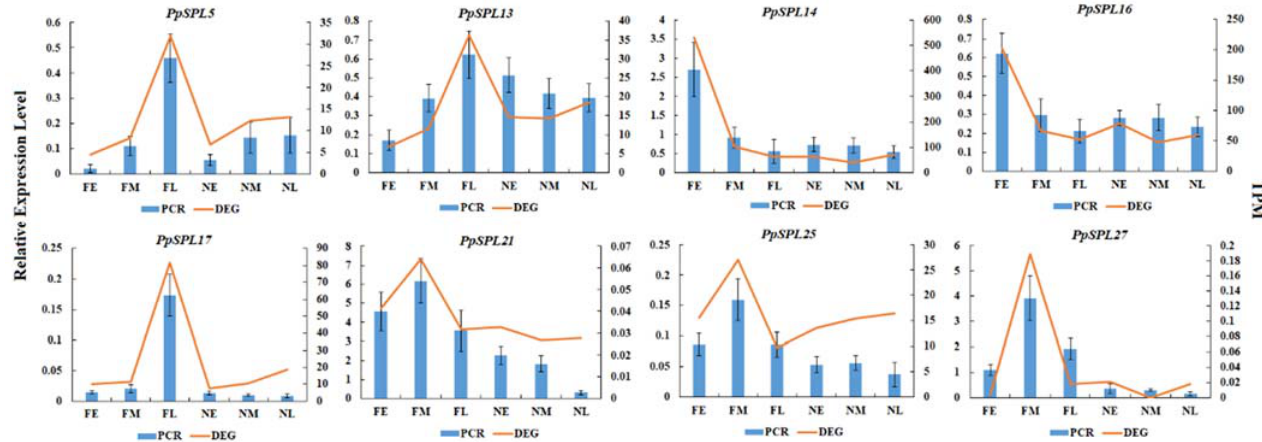
Figure 6. RT-qPCR validation of significant, differentially expressed PpSPLs in Pleioblastus pygmaeus . FE, dormant shoot buds from flowering P. pygmaeus ; FM, germinated shoots from flowering P. pygmaeus ; FL, flower buds from flowering P. pygmaeus ; NE, dormant shoot buds from non-flowering P. pygmaeus ; NM, germinated shoots from non-flowering P. pygmaeus ; NL, leaf buds from non-flowering P. pygmaeus ; PCR, relative expression level by RT-qPCR; DEG, differentially expressed gene by RNA- Seq; TPM, Transcripts Perkilobase Million. Red lines represent the mRNA abundance of SPLs by RNA-Seq analysis. Blue bars represent the relative expression level of SPLs by RT-qPCR. Mean values and deviations were calculated from three independent biological